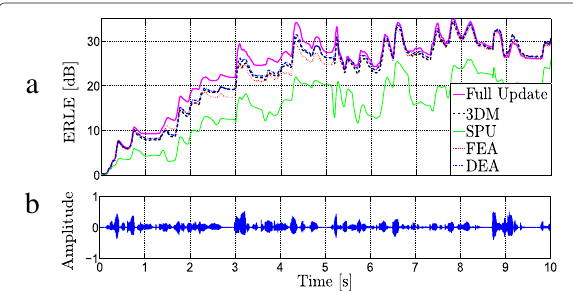
Fig. 11 ( a ) ERLE curves obtained for full update ( Q = 1) and for different tap selection schemes ( Q = 0.2) for a 10-s segment of a mono speech signal; ( b ) waveform of the 10-s segment of a mono speech